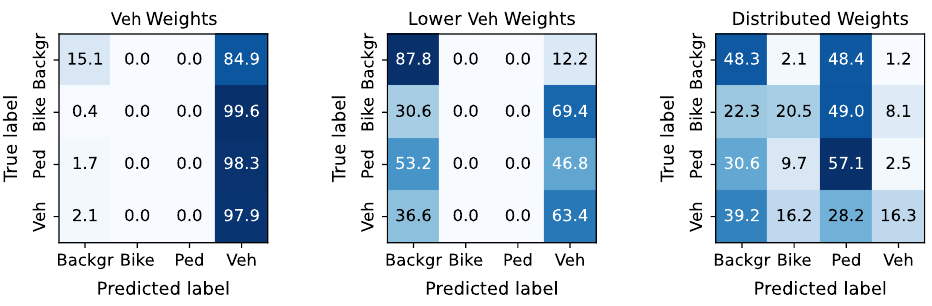
Figure 7. Segmentation confusion matrices for different class weight configurations of the data set classes.